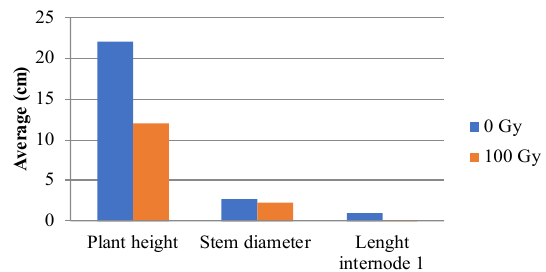
Figure 6.Effects of 100 Gy gamma irradiation on the stem characteristics of the M1 generation of coffee ( Coffea arabica L. var. typica) plants grown under nursery conditions on “Genova Farm San Ramon District, Department of Junín, Peru.